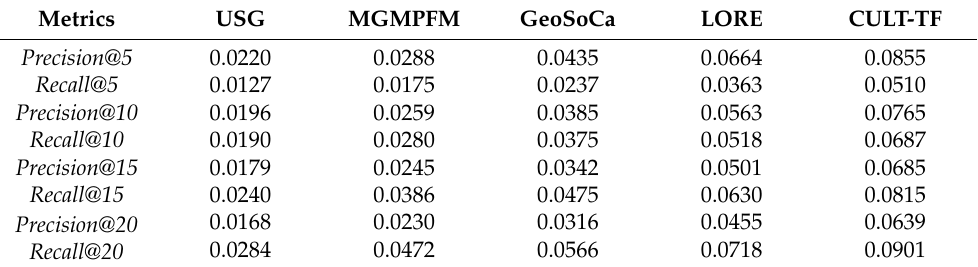
Table 5. Precision and recall of different recommendation